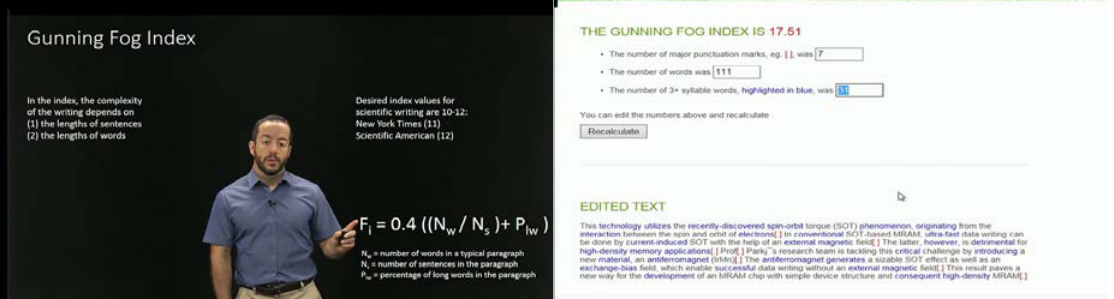
Figure 2 . (Left) A still from a Treatment Group 2 video lecture (medium low diversity). (Right) A second still from the same Treatment 2 video featuring an addition visual not shown in Treatment 1.